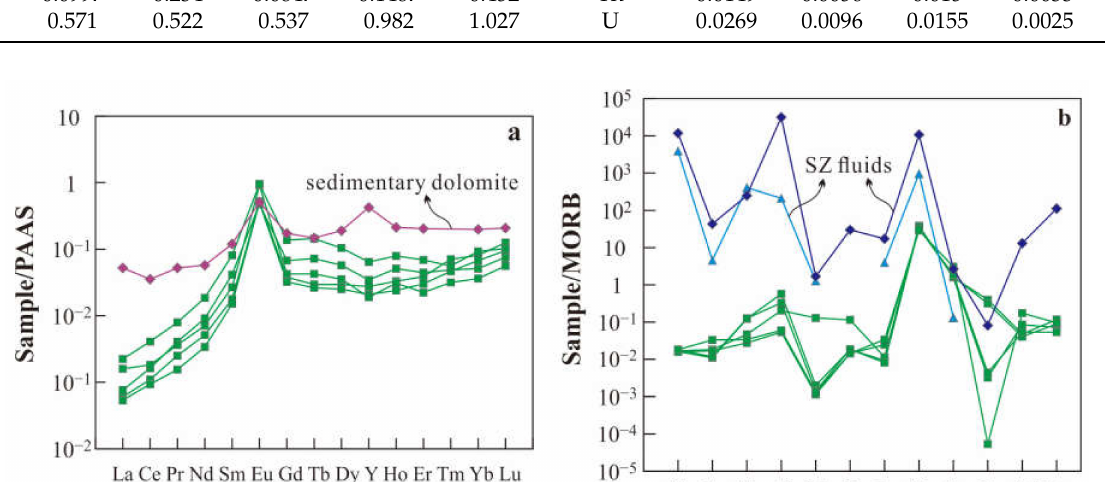
Figure 4. ( a ) Post-Archaean Australia shale (PAAS)-normalized REE patterns of dolomite from the chlorite schist (squares). The representative sedimentary dolomite is also shown (diamonds, data from [64]). ( b ) MORB-normalized trace element patterns of dolomite from the chlorite schist (squares). Experimentally determined subduction zone (SZ) fluids are also shown (diamonds: Cl-present; triangles: Cl-free; data from [65]). Elements are plotted in order of decreasing compatibility, in accordance with